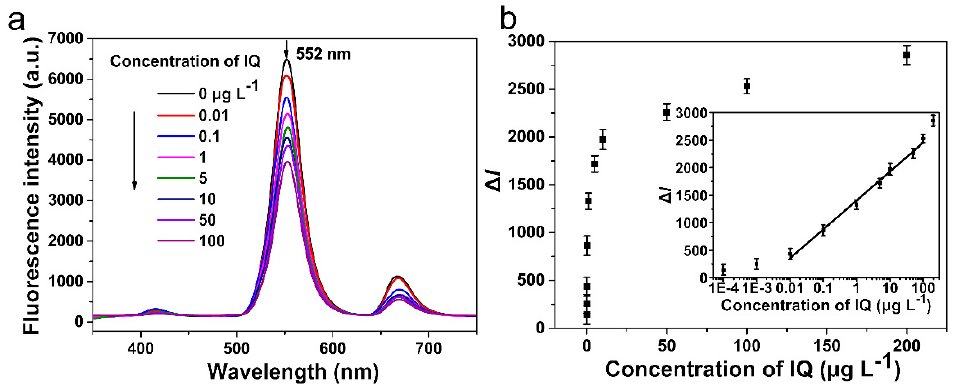
Figure 5. Detection of 2-amino-3-methylimidazo [4,5-f] quinoline (IQ) with fluorescence immunoassay. ( a ): Fluorescence intensity of the immune complexes with varying concentrations of IQ, ( b ): Standard curve of the fluorescence immunoassay for IQ in the PBS buffer. Each value is mean of three replicates.